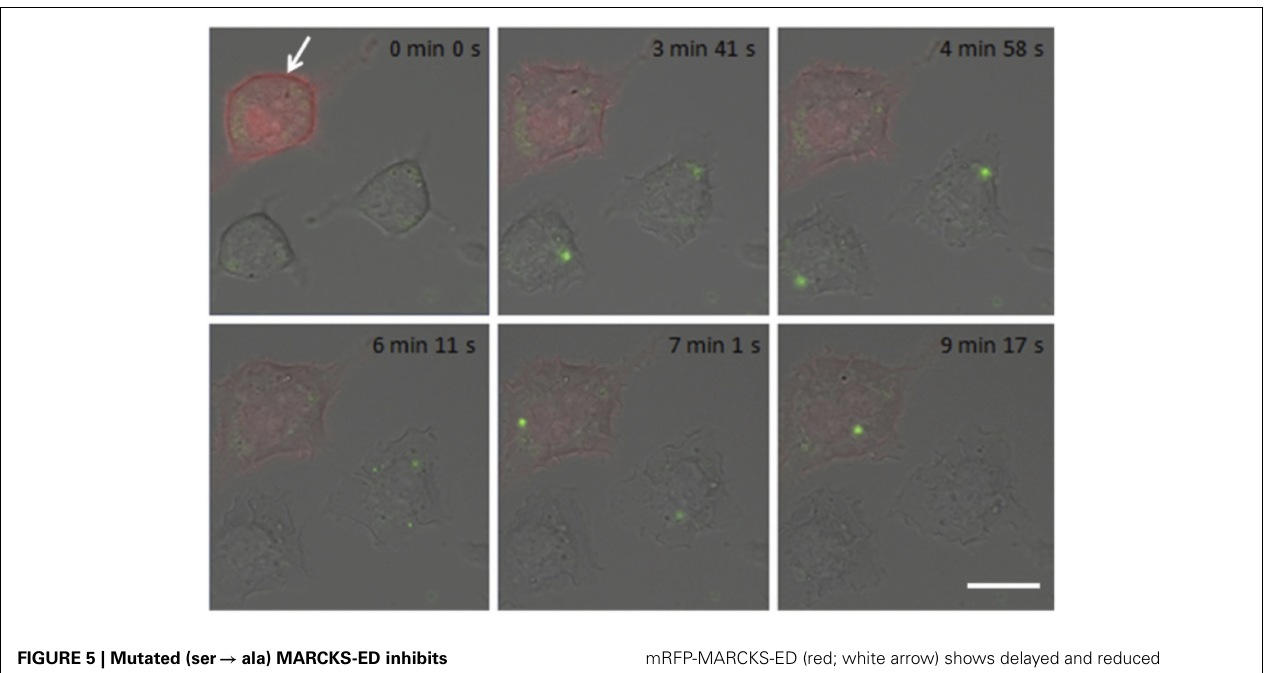
FIGURE 5 | Mutated (ser → ala) MARCKS-ED inhibits antigen-stimulated degranulation. In real-time imaging, degranulation is monitored as FITC–dextran bursts (green puncta) from antigen-stimulated RBL cells. Representative cell expressing mutated